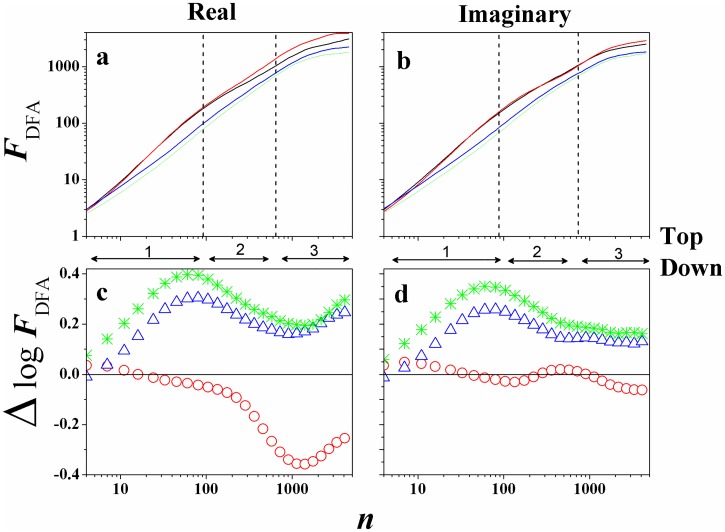
(Color on-line) FDFA in function of n for S020 in the experiment 1 for (Top/Down): (a) Real and (b) Imaginary case. Black line represents F332, red line F637, blue line P349, and green line P654. Also, the figures below show the difference ΔlogF32;xx, defined by Eq 2, between the channels for the above function FDFA: (c) Real and (d) Imaginary case. Here, ΔlogF32;37 (∘), ΔlogF32;49 (△), and ΔlogF32;54 (*).